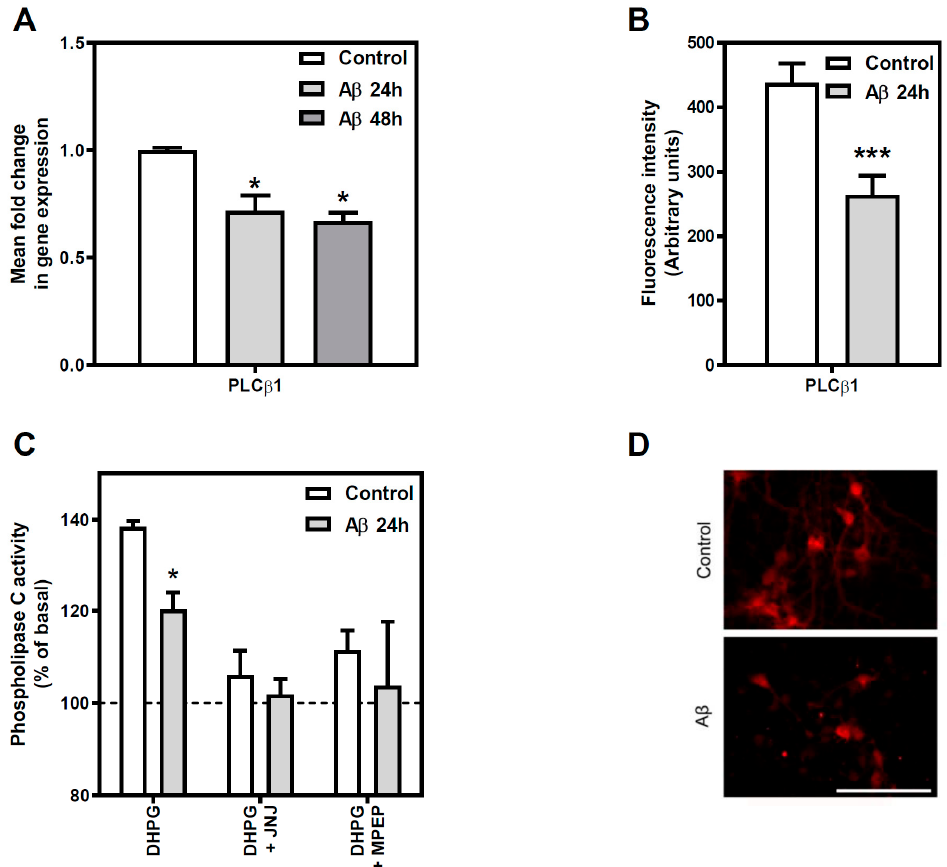
Figure 3. Effect of A β 25-35 exposure on Group I mGluR-mediated PLC pathway in cortical neurons. ( A ) Effect of A β 25-35 treatment on PLC β 1 gene expression was measured using qPCR. Rat cortical neurons were exposed to 25 µM A β 25-35 for 24 h and 48 h or maintained under control conditions prior to RNA isolation. Quantitative real time PCR assays were performed as described in Methods. Data are means ± SEM of, at least, three independent RNA isolations and their quantitative PCR replicates. * p < 0.05 significantly different from control value using one-way ANOVA and Bonferroni’s post hoc test. ( B ) Effect of A β 25-35 treatment on PLC β 1 protein level was measured using immunohistochemistry. Data are means ± SEM of, at least, three independent experiments performed in duplicate using different preparations. *** p < 0.001 significantly different from untreated condition using two tailed Student´s t -test. ( C ) Group I mGluR-mediated PLC activity was measured under control and treated conditions. Stimulation of phosphoinositide breakdown was measured in intact neurons exposed to 25 µM A β 25-35 for 24 h or maintained under control conditions. Group I mGluR-mediated PLC activity was stimulated using 30 µM DHPG for 10 min in control and A β -treated cortical neurons. The specificity of the assay was tested using the antagonists JNJ 16259685 and MPEP at concentrations of 0.5 µM and 1 µM, respectively. Results are expressed as a percentage of the basal (unstimulated) activity in the absence of DHPG (basal values: control 26.81 ± 7.27; A β 25-35 treated 17.61 ± 4.85 pmol/mg·min). Data are means ± SEM of, at least, three independent experiments performed in duplicate using different cultures. All sets of data were significantly different (at least p < 0.05) from their corresponding basal value. * p < 0.05, significantly different from control value using two tailed Student´s t -test. ( D ) Representative images of immunochemistry experiments presented in panel B are shown for control and 25 µM A β 25-35 exposed cells for 24 h. Bar represents 100 µm.